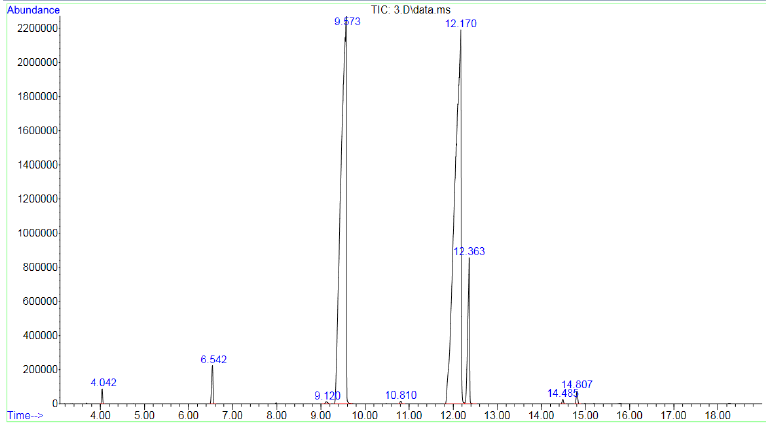
Figure 1. Chromatogram of palm oil biodiesel. Table 1. Palm oil biodiesel fatty acid composition.